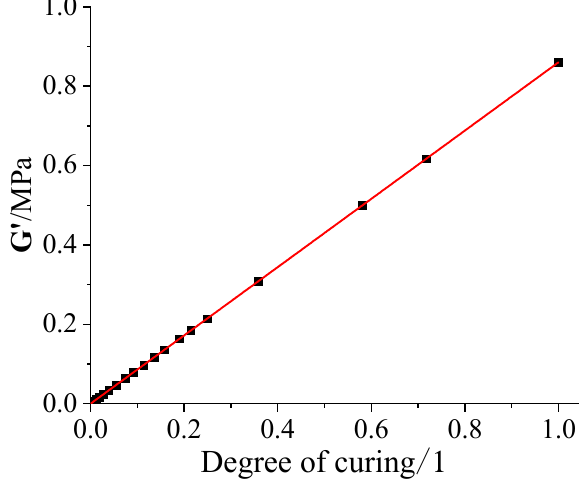
Figure 3. Storage modulus vs. curing degree.